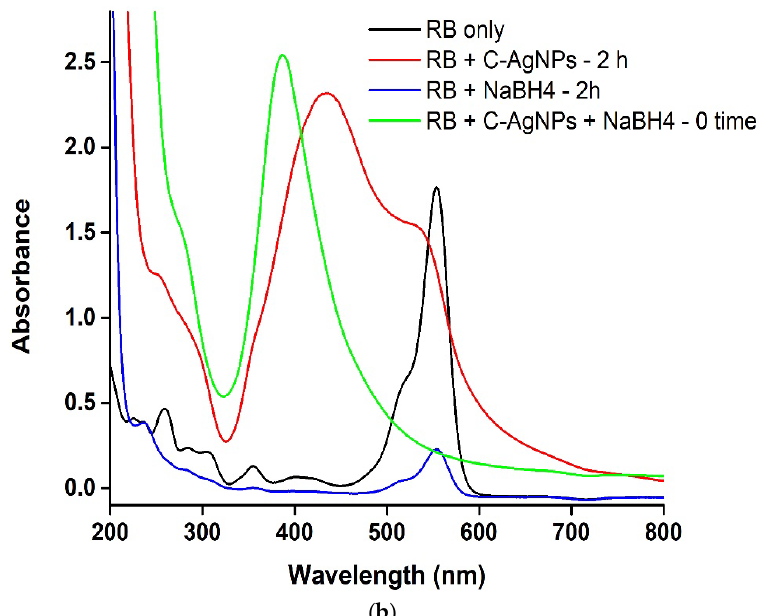
Figure 13. UV-Visible spectra of catalytic reductions of ( a ) methylene blue and ( b ) rhodamine B, alone, with C-AgNPs and NaBH 4 separately, and with both C-AgNPs and NaBH 4